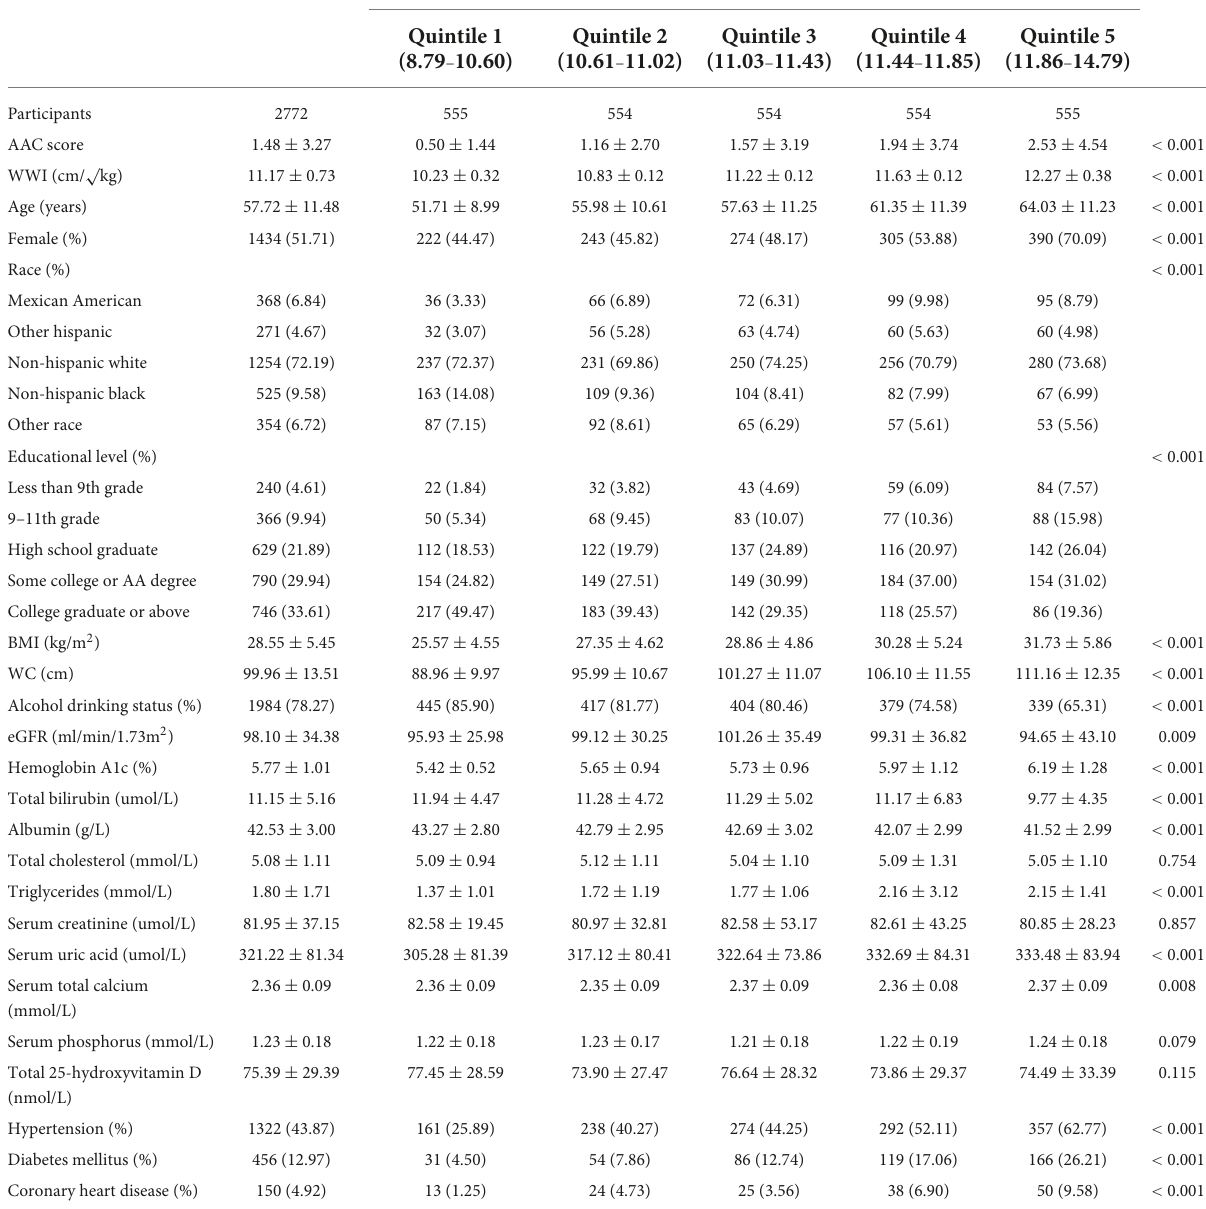
TABLE 1 Baseline characteristics of all participants stratified by quintiles of weight-adjusted-waist index